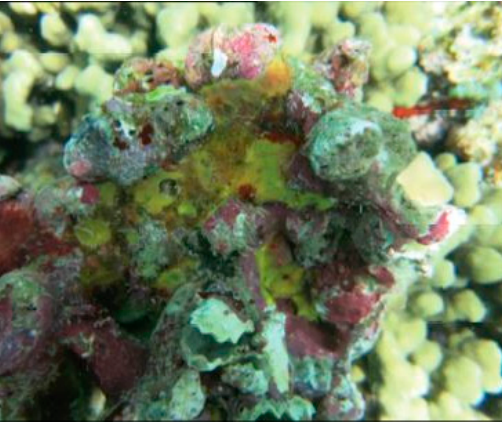
Figure 2. Specimen of Pseudoceratina purpurea demosponge [37].